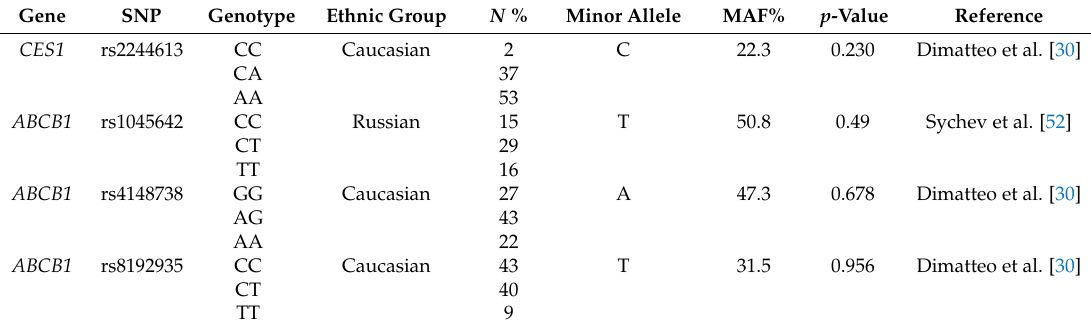
Table 6. Genotype distributions of common variants of ABCB1 and CES1.